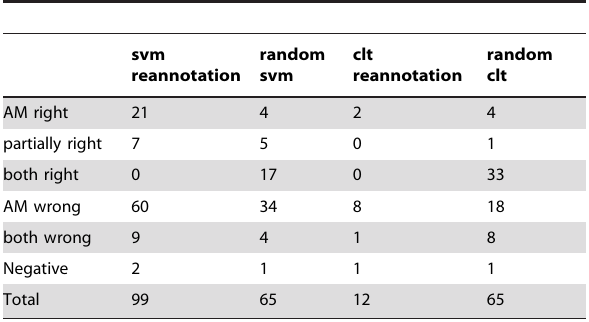
Table 2. Summary of first round reannotation